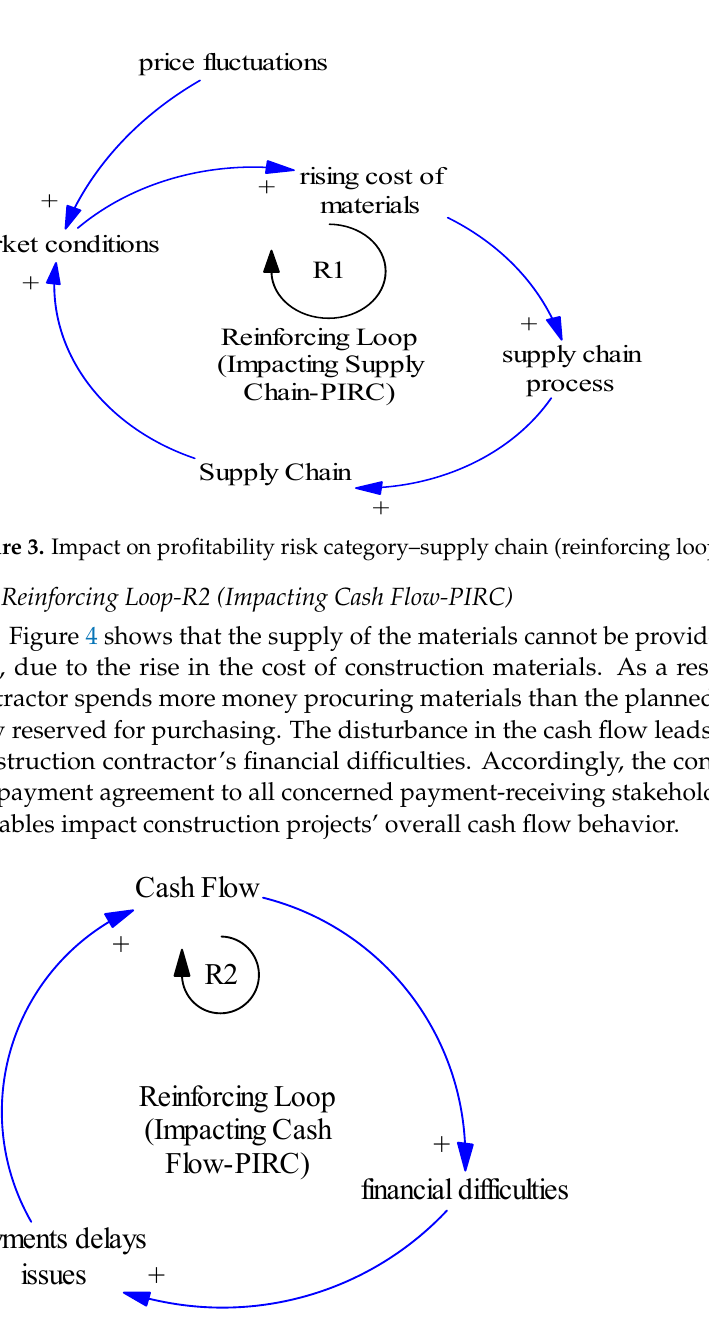
Figure 4. Impact on profitability risk category–cash flow (reinforcing loop-R2).